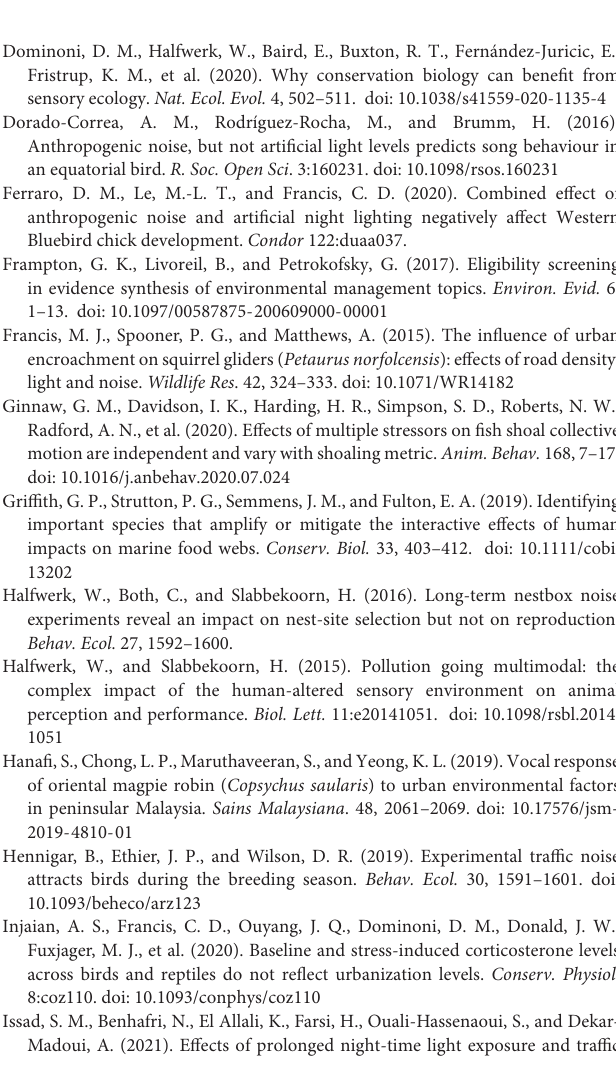
Supplementary Figure 1 | Flow chart of the systematic review process detailing numbers of studies identified at each stage. Supplementary Data Sheet | Data for each stage of the systematic review process, comprising separate spreadsheets for the initial Web of Science search, included studies from the initial Web of Science search, articles citing the included studies (with and without duplicates removed), and the final list of all included